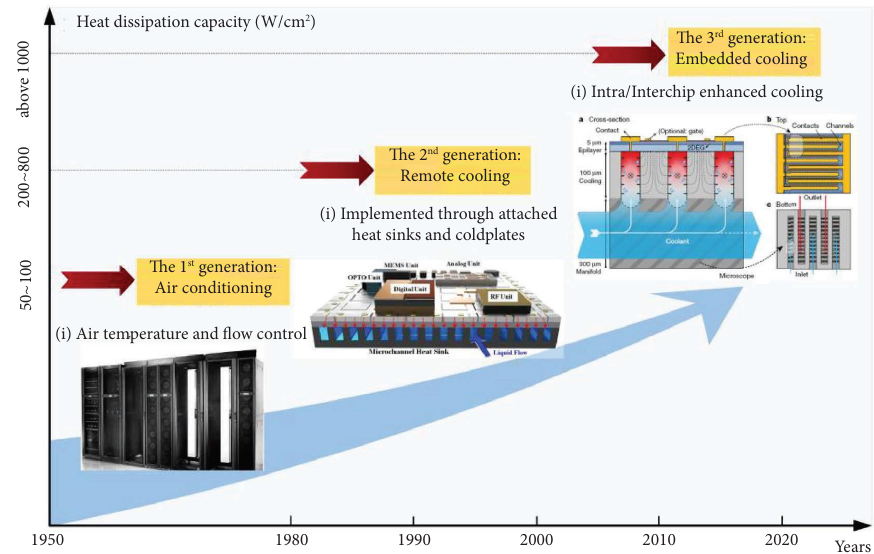
Figure 13: Development of heat dissipation